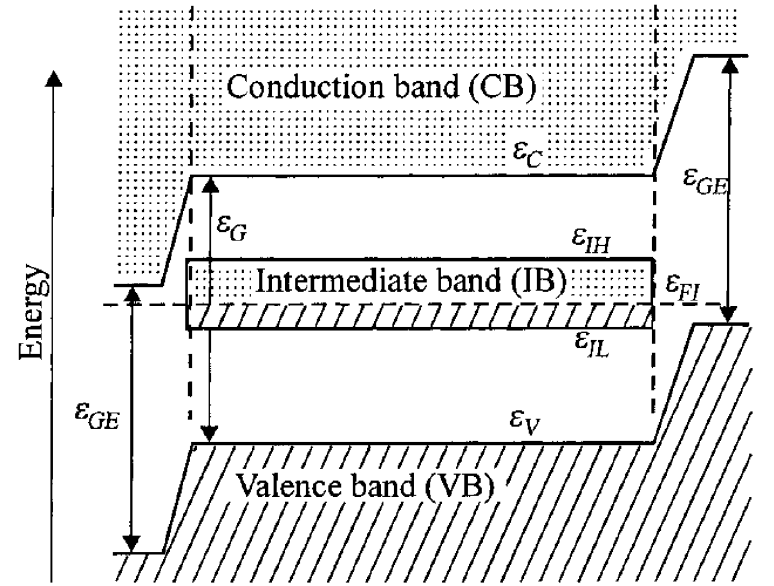
Figure 13. Sketch of an intermediate band (IB) energy band diagram in thermal equilibrium showing the energy band extremes. Dashed and dotted regions correspond to electron-filled and empty bands, respectively (at 0 K). Reprinted from [150] with the permission of John Wiley and Sons.